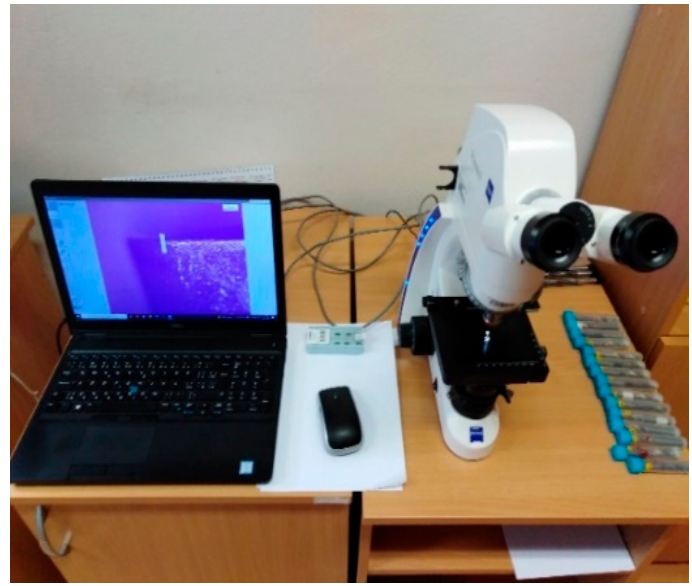
Figure 8. Measurement and analysis of flank wear on the cutting insert by Carl Zeiss Primotech D/A ESD microscope.